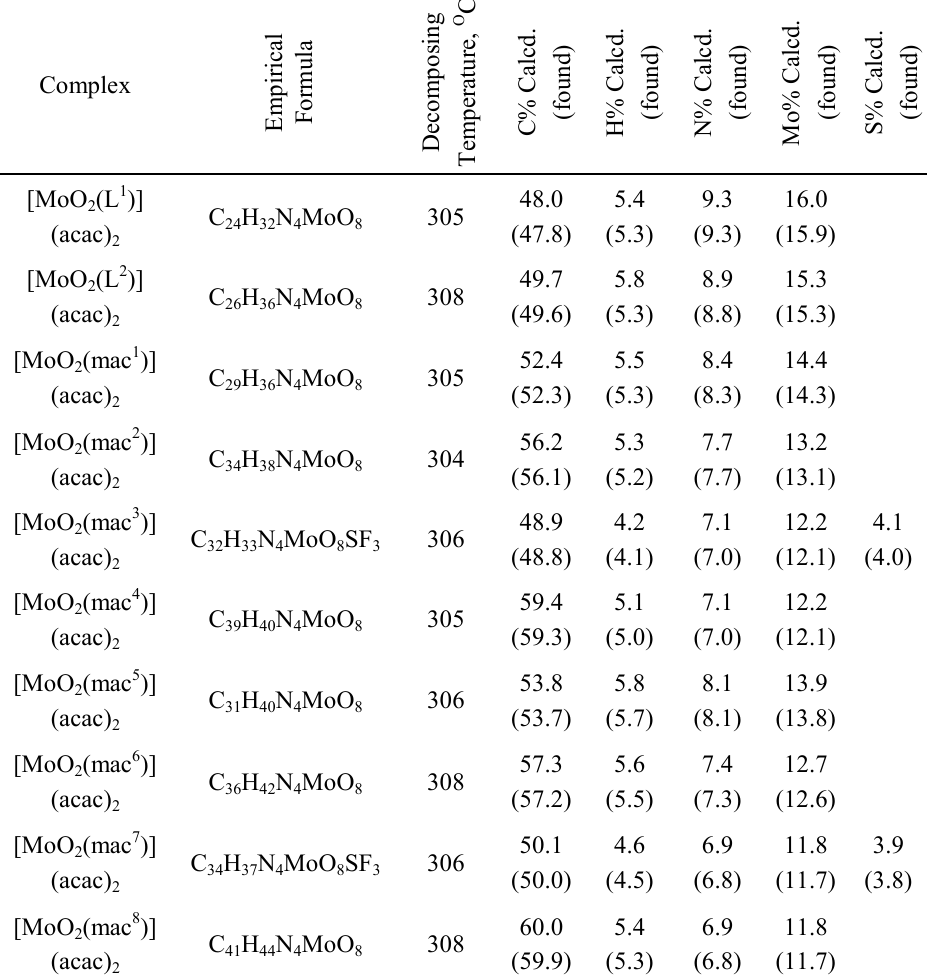
Table 1. Physical and Analytical data of the